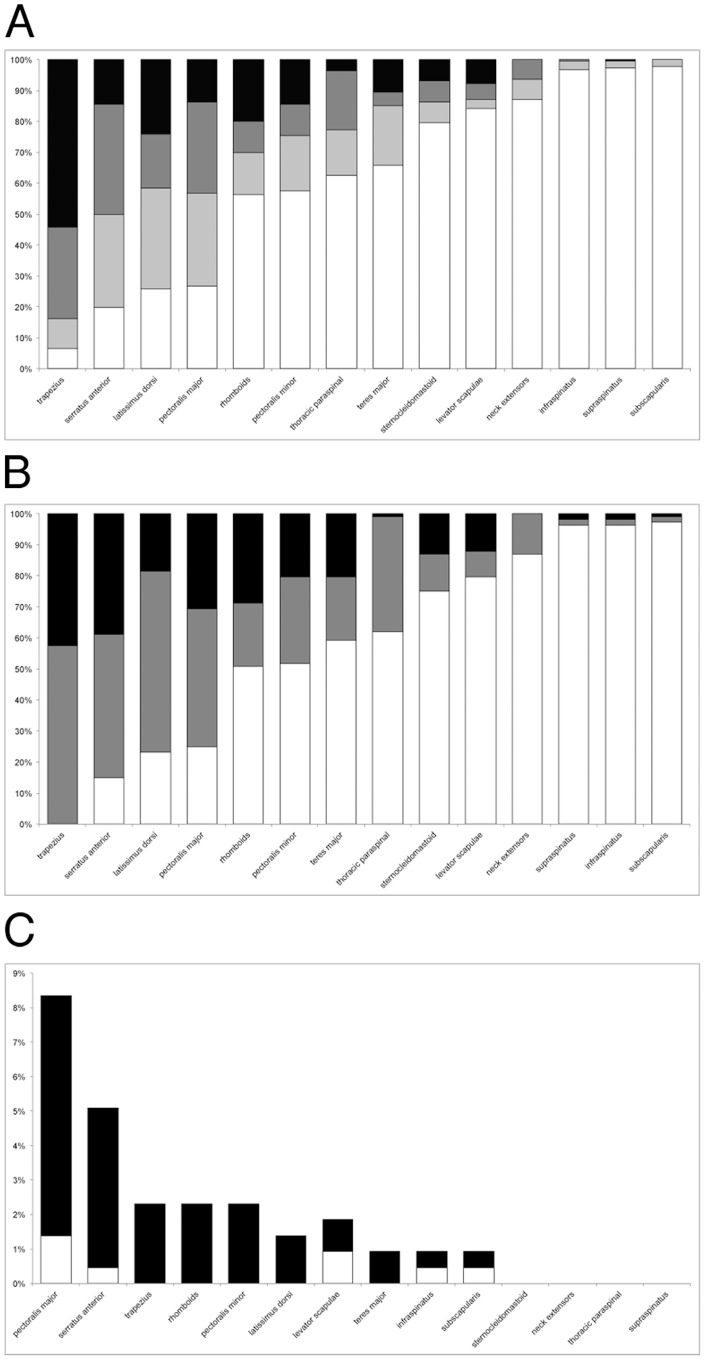
Summary of muscle involvement in FSHD.(A) Percentage of involvement of the different muscles. White columns: unaffected; light gray columns: affected with score 1; dark gray columns: affected with score 2; black columns: affected with score 3. (B) Frequency of symmetrical and asymmetrical involvement of individual muscles across all the patients. White columns: unaffected; gray columns: affected symmetrically; black columns: affected asymmetrically. (C) Percentage of involvement on STIR sequences of T1-W normal (white) or abnormal (black) muscles.